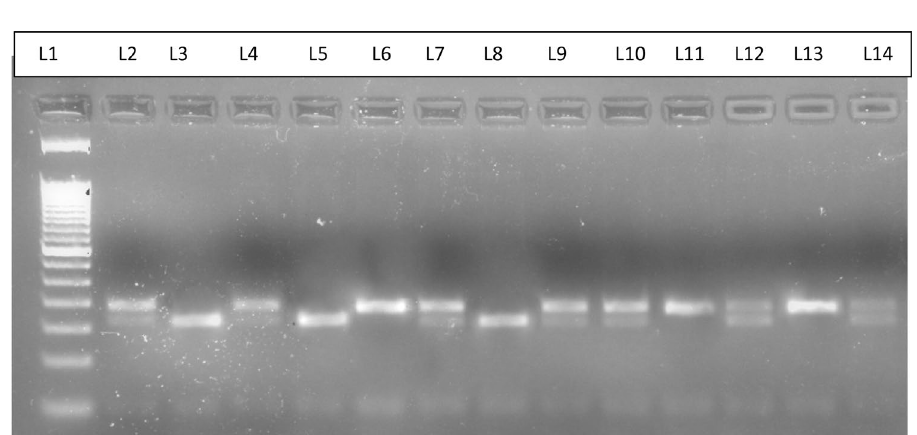
Figure 3. Representative picture for Restriction digestion of CYP19 with CviAII. L1 represents 50 bp ladder; L6, L11, L13-represent wild genotype (189 bp); L3, L5, L8-represents mutant genotype (161 and 28 bp); L2, L4, L7, L9, L10, L12, L14-represents heterozygous genotype (189, 161 and 28